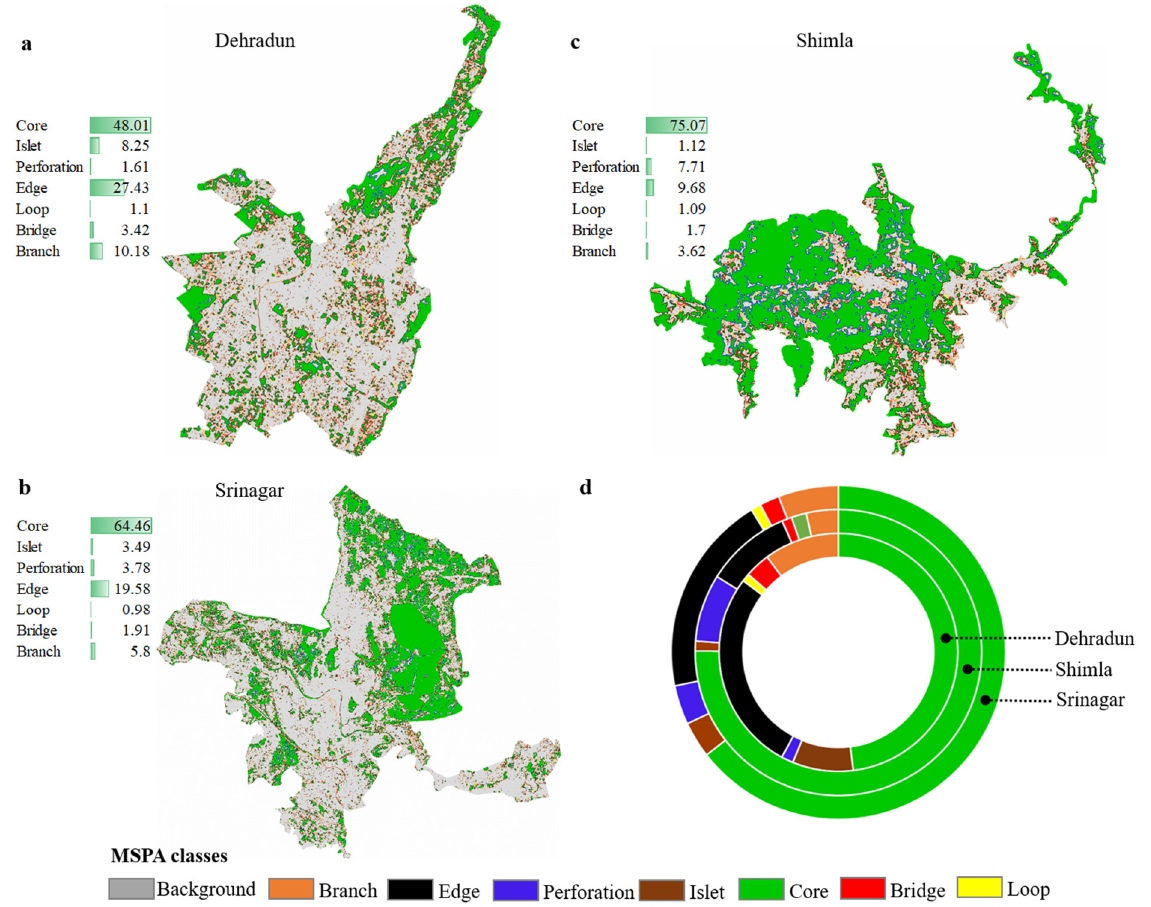
Figure 9. Spatial distribution of MSPA classes for ( a ) Dehradun, ( b ) Srinagar, and ( c ) Shimla and ( d ) their percentage distribution.